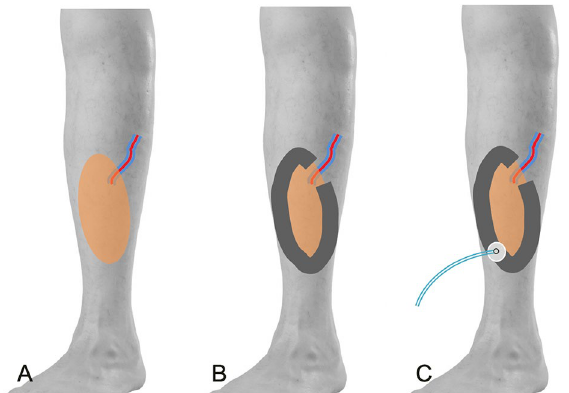
Figure 1. ( A ) The defect was managed with fasciocutaneous flap coverage, and surgical closure had been completed. ( B ) U-shaped foam dressing was applied along the suture line of the flap. The opening of the foam dressing prevents compression over the path of the vessel pedicles to flap. ( C ) The NPWT machine was set with the tubing and suction connector on the opposite side of the vessel